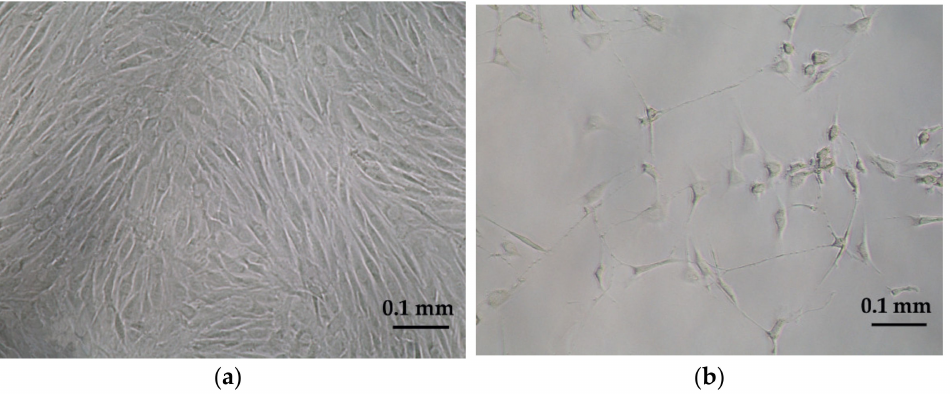
Figure 1. oBM-MSC differentiation into neuron-like cells 3 days after neurogenic induction with HyClone neurogenic medium: ( a ) oBM-MSCs in growth conditions and ( b ) oBM-MSCs in neurogenic